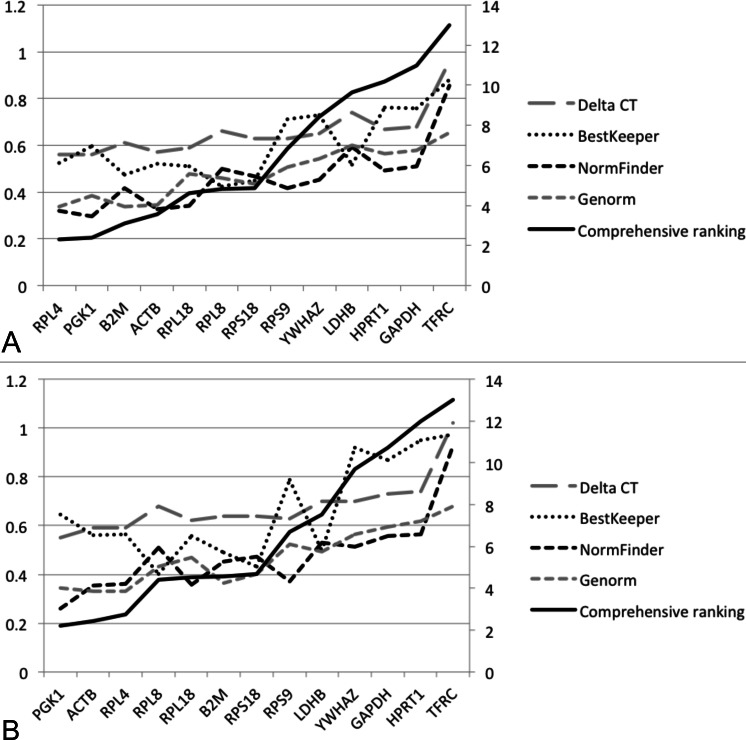
Stability values and ranking orders determined by four algorisms and RefFinder: (A) 60 samples; (B) 30 samples.